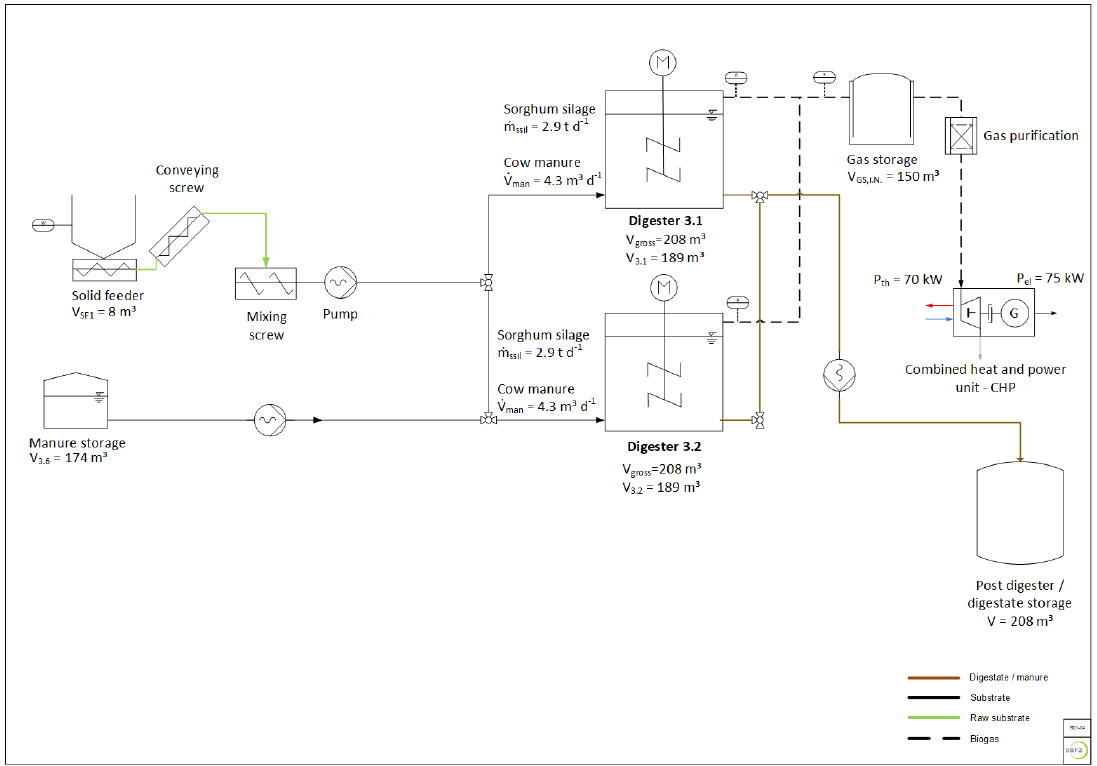
Figure 1. Scheme of the research biogas plant at Deutsches Biomasseforschungszentrum (DBFZ).